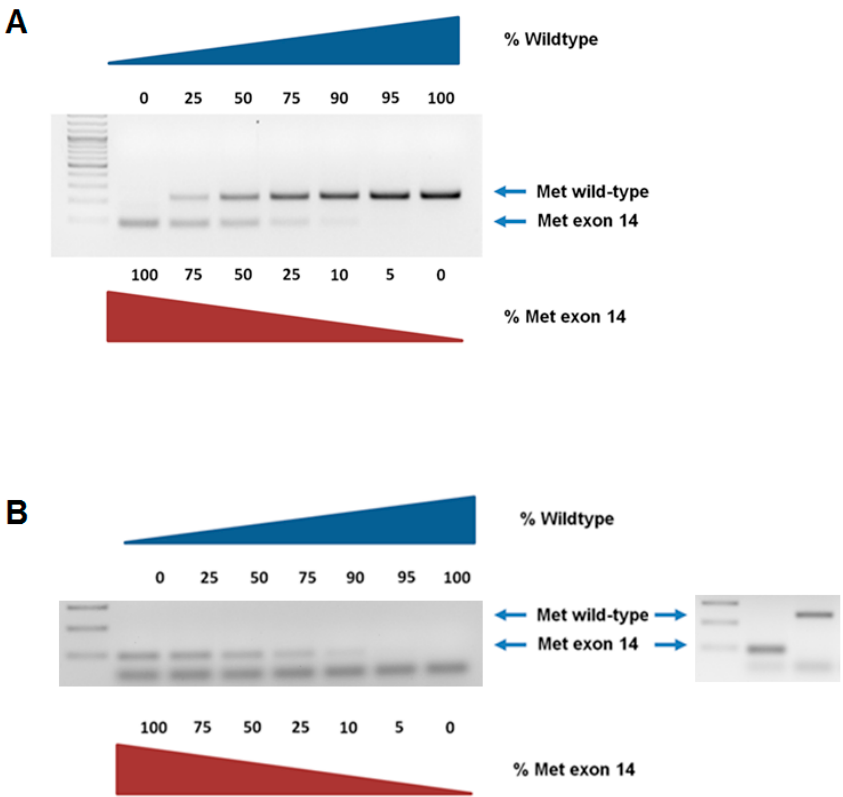
Figure 2. Assay sensitivity for end ‐ point PCR detection of METex14 skipping. Sensitivity to detect MetEx14 was measured using either ( A ) GBlocks or ( B ) admixtures of patient FFPE RNA with limiting amounts/percentages of WT/METex14 as indicated. The limit of detection was found to be 10%.